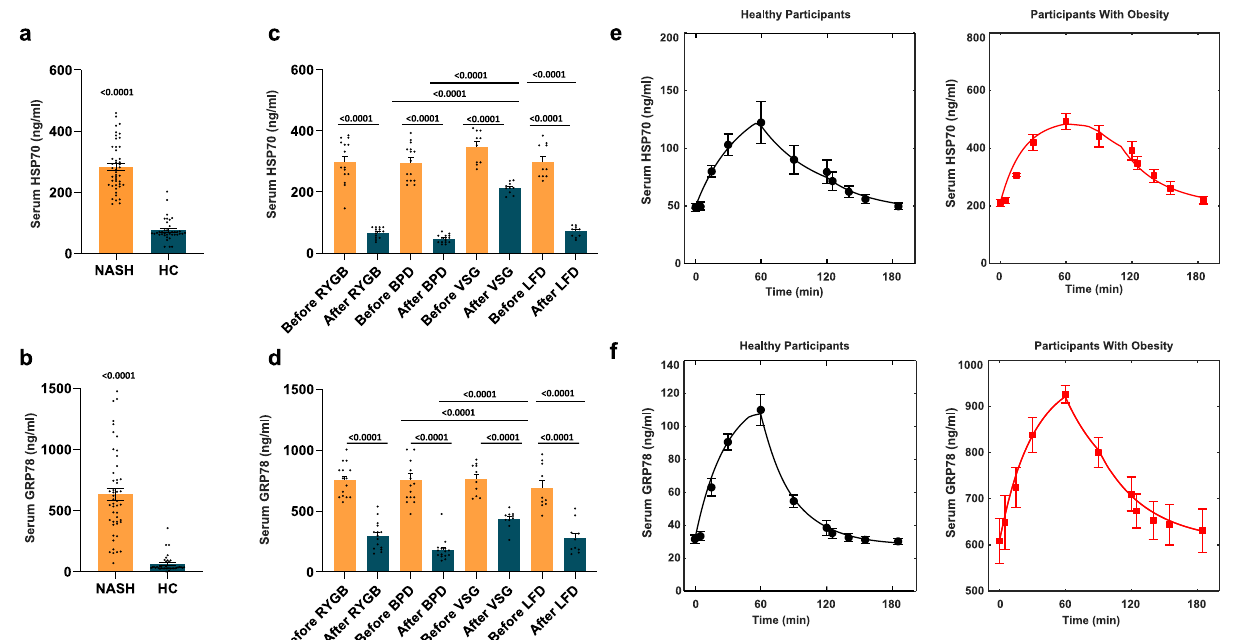
Fig. 8 | Human studies. a , b Fasting serum levelsof HSP70 ( a ) and of GRP78 ( b ) in people with Non-Alcoholic Steato-Hepatitis (NASH) ( n =47 biologically indepen- dent samples) and in healthy participants ( n =39 biologically independent sam- ples). c , d Serum levels of HSP70 ( c ) and of GRP78 ( d ) before and after Roux-en-Y Gastric Bypass (RYGB), Biliopancreatic diversion (BPD) ( n =15 biologically inde- pendent samples), Vertical Sleeve Gastrectomy (VSG) and Low-Fat Diet (LFD)